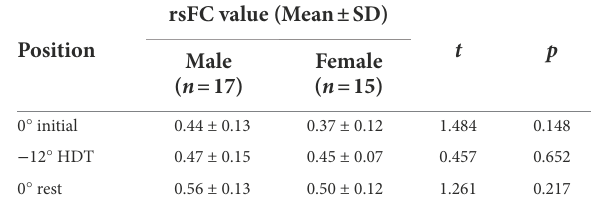
TABLE 4 Comparison of rsFC values between men and women in different